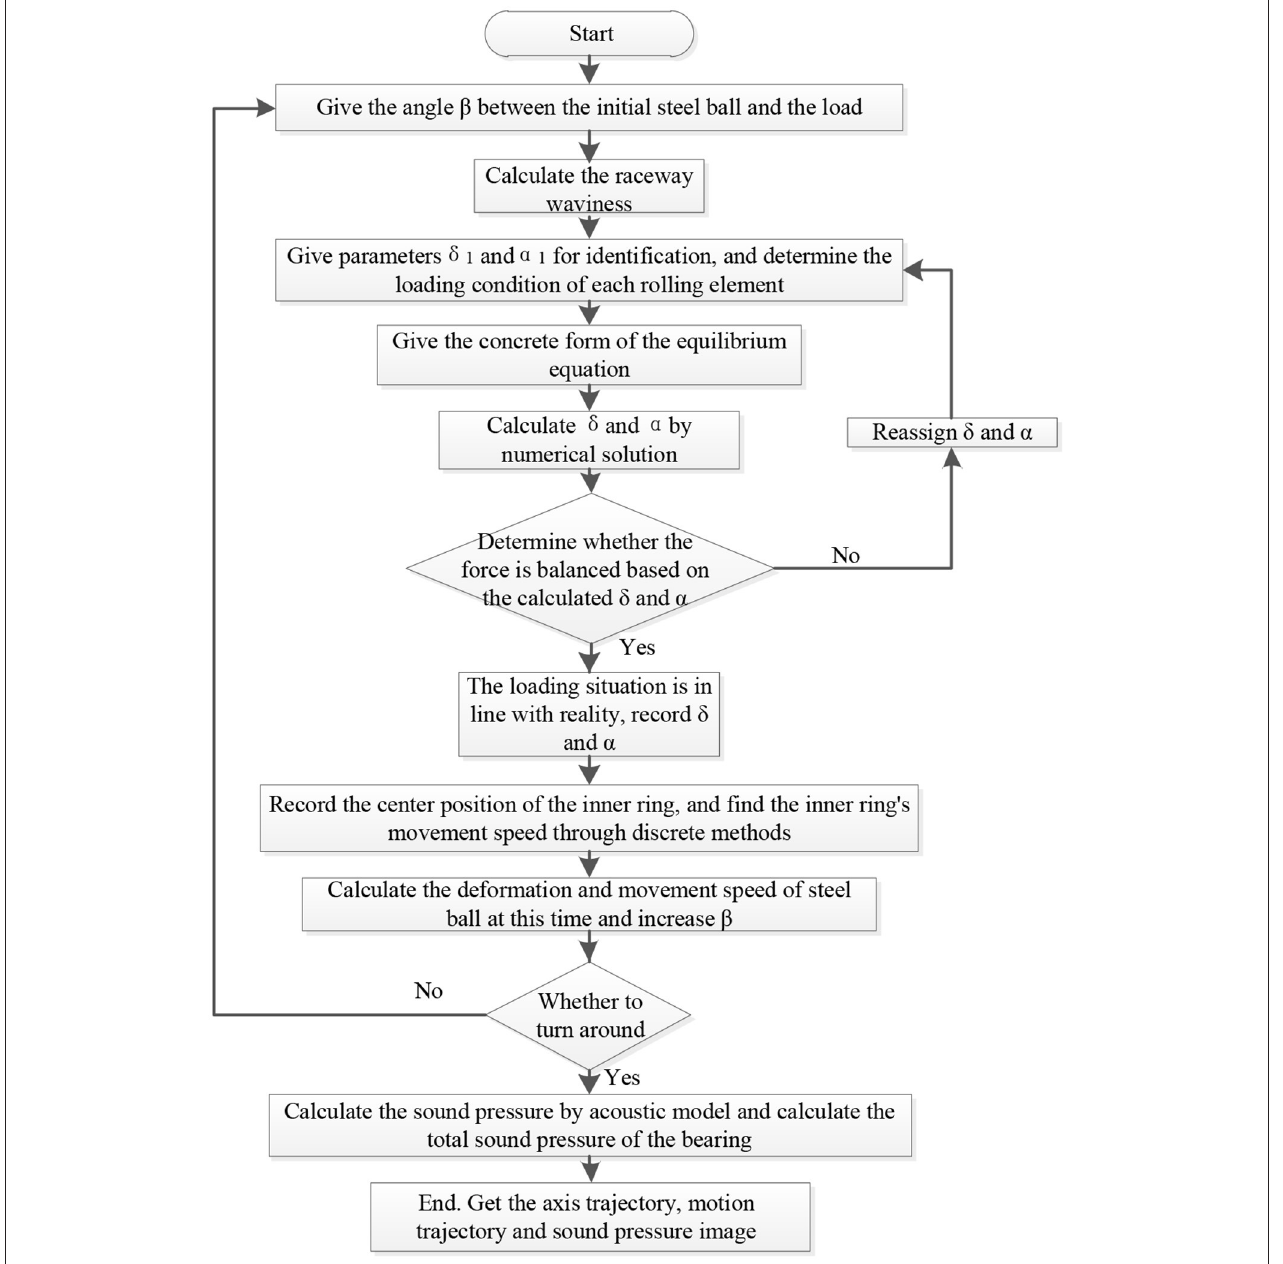
FIGURE 8 | Calculation flow